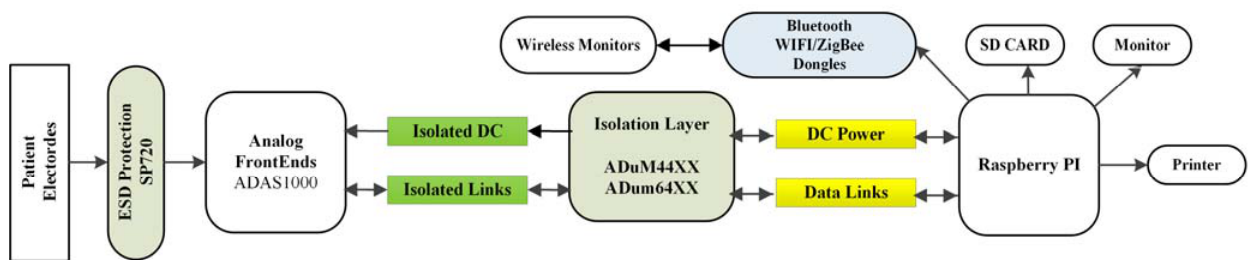
Figure 3. System Architecture: Analog front-end, Raspberry PI (RPI),